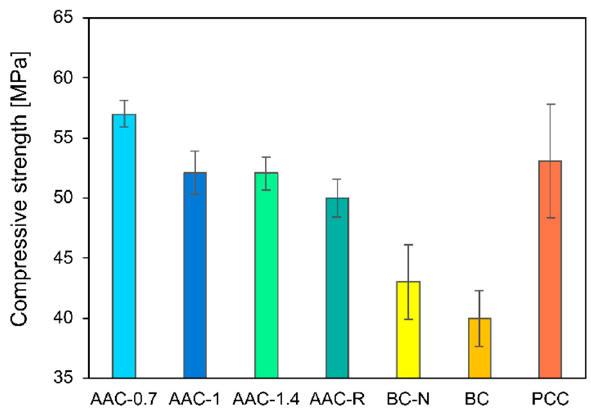
Figure 4. Compressive strength test results.